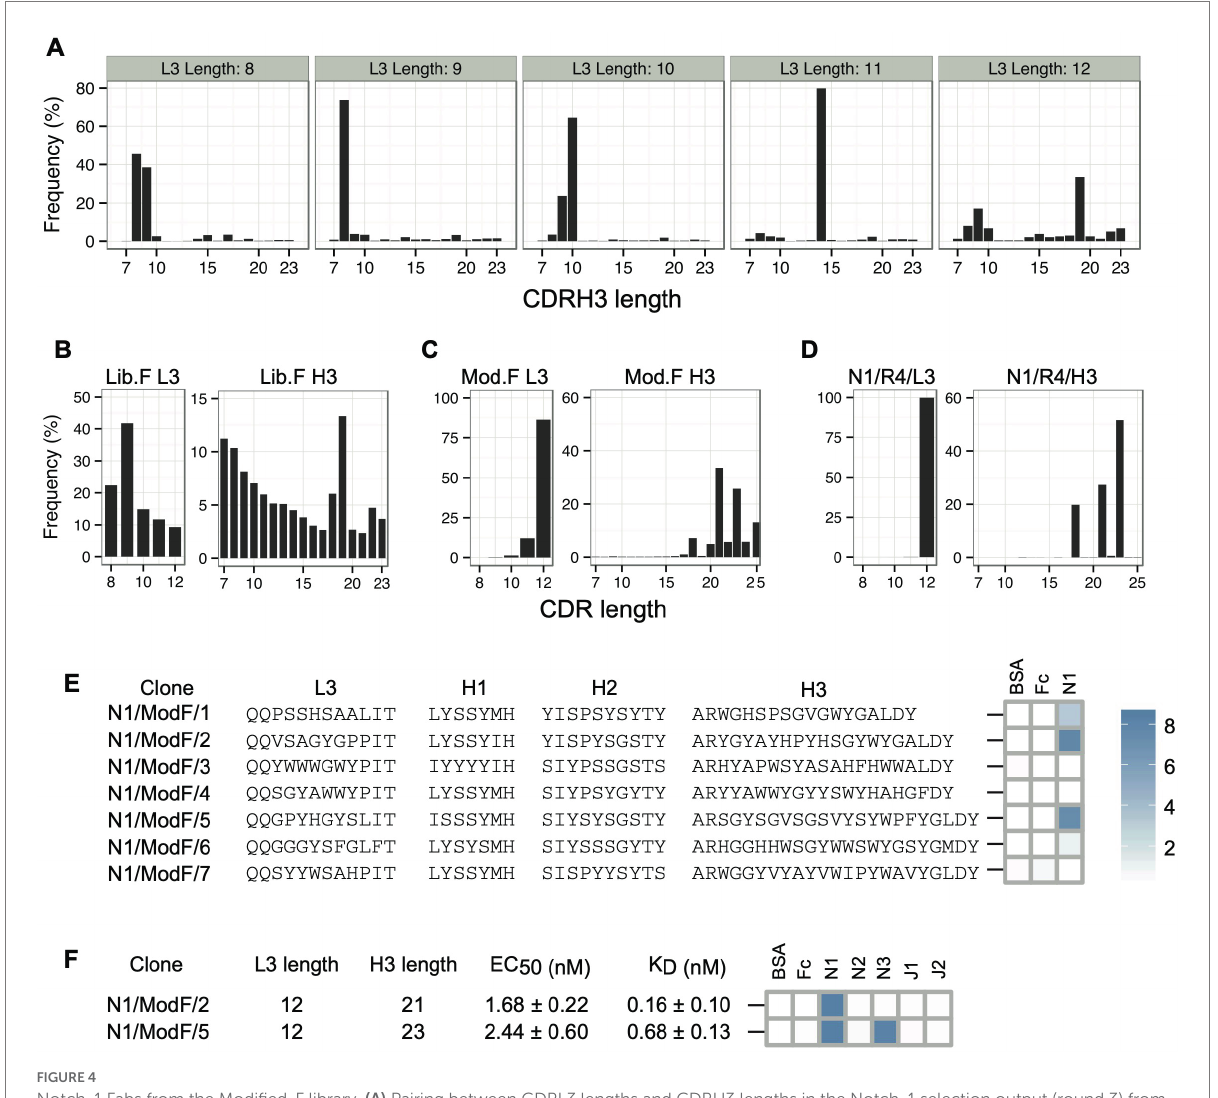
FIGURE 4 Notch-1 Fabs from the Modified-F library. (A) Pairing between CDRL3 lengths and CDRH3 lengths in the Notch-1 selection output (round 3) from Library-F selections. L3-H3 pairs were obtained from L3-H1-H2-H3 NGS information, and for each possible L3 length, H3 length distribution was generated. (B) CDRL3 and CDRH3 length distribution of the naïve Library-F. (C) CDRL3 and CDRH3 length distribution of the Modified-F library. (D) CDRL3 and CDRH3 length distribution of the Notch-1 selection output after four rounds of selection with the Modified-F library. (E)